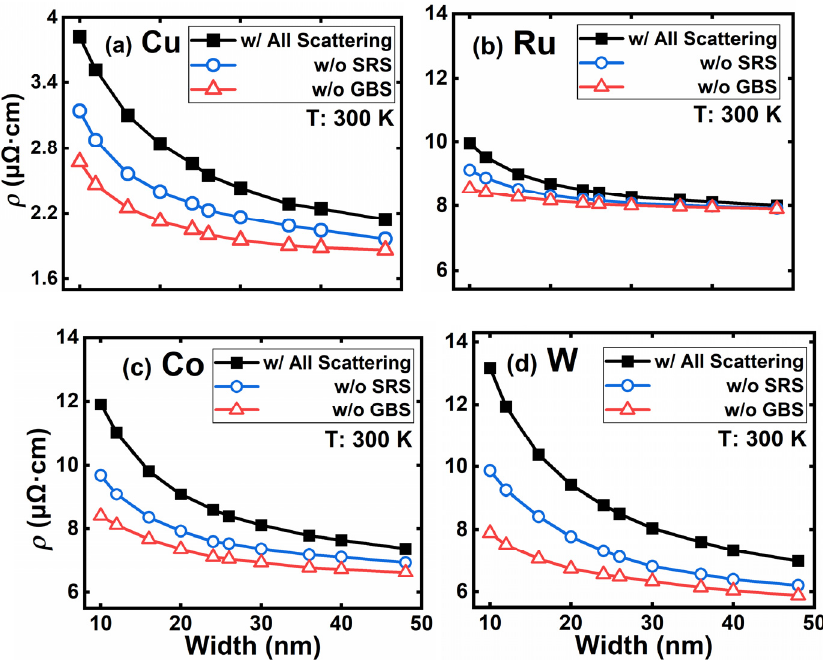
Figure 4. The resistivity of ( a ) Cu, ( b ) Ru, ( c ) Co, and ( d ) W interconnects with a linewidth ranging from 10 to 48 nm.